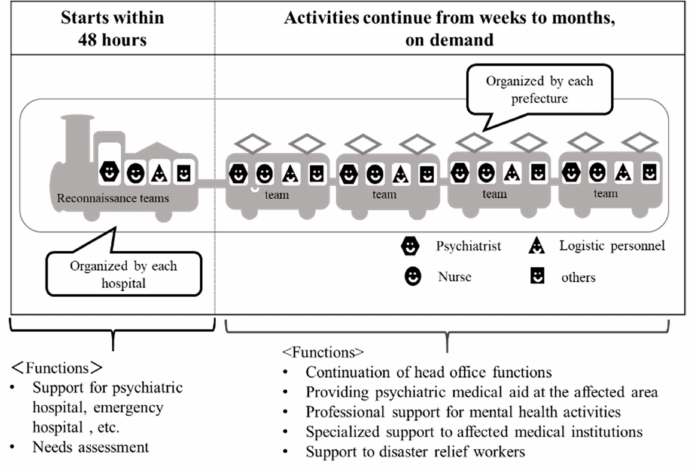
Figure 2. The roles of the reconnaissance Disaster Psychiatric Assistance Team (DPAT) and subsequent DPAT teams.